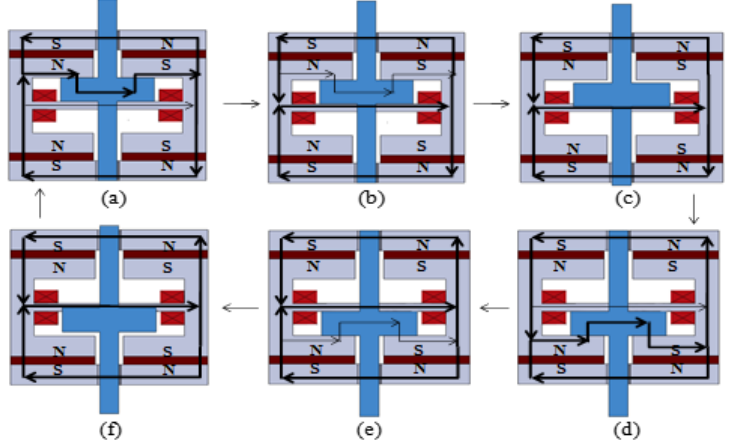
Figure 3. Magnetic circuit diagram of the EM valve: ( a ) the armature is attracted by the upper magnet; ( b ) the magnetic flux is directed by the guiding coil; ( c ) the armature is released downward; ( d ) the armature is attracted by the lower magnet; ( e ) guided by the coil; ( f ) the armature is released upwards [15].